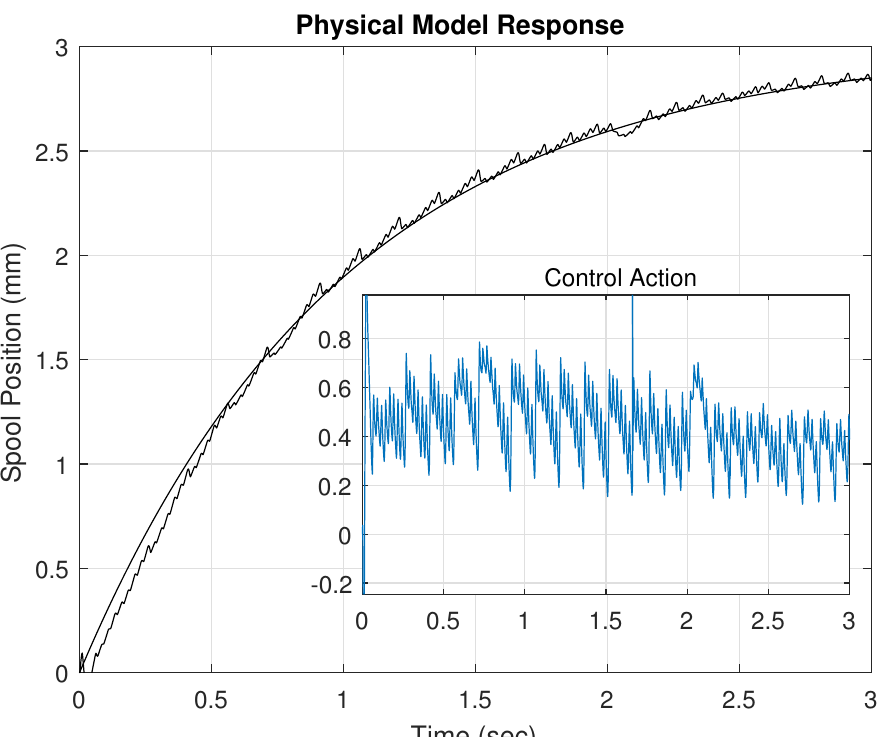
Figure 13. Spool position and control action for aperiodic